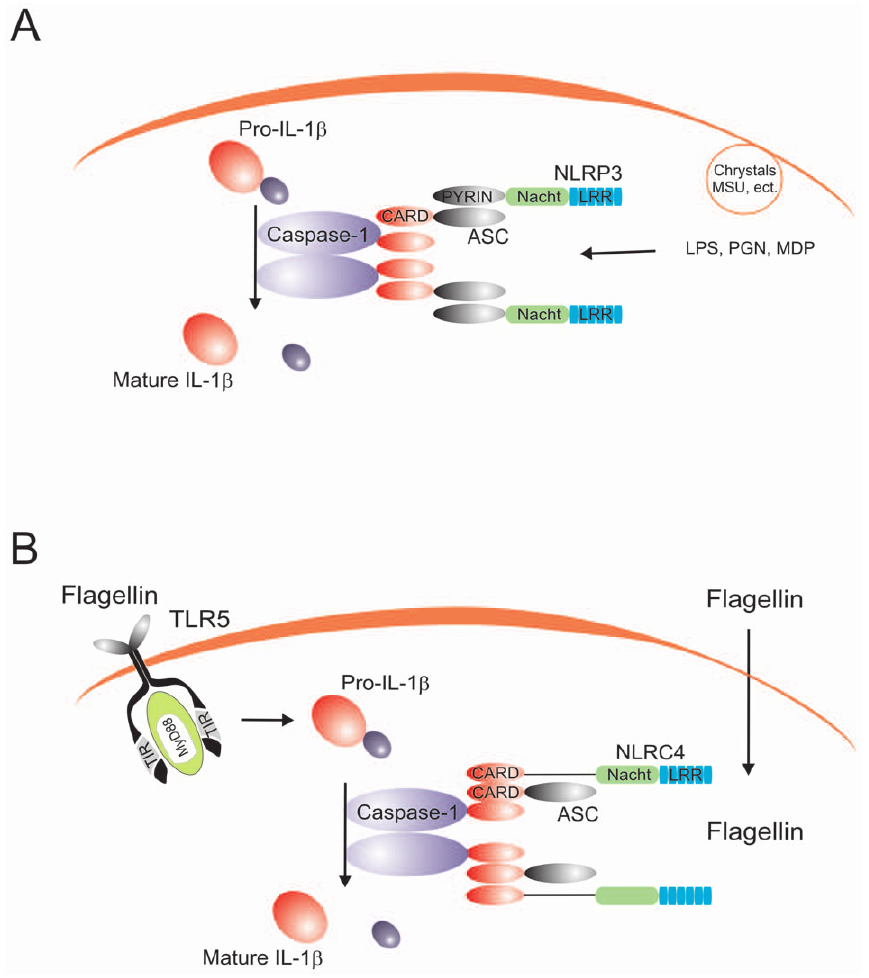
Figure 1. The prototypical NLRP3 and NLRC4 inflammasomes. (A) The NLRP3 inflammasome is activated by both bacterial (e.g., MDP, bacterial RNA, b -glucan), exogenous (e.g., silica, alum), and endogenous (e.g., uric acid cristals, ATP) stimuli. (B) The NLRC4 inflammasome is activated by flagellin in a TLR5-independent fashion.